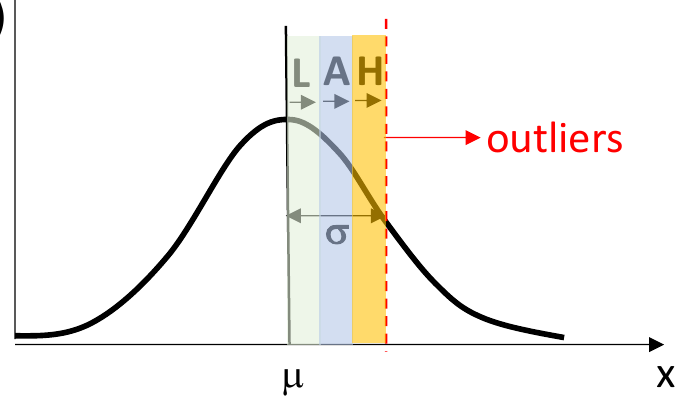
Figure 11. UX scoring and outliers condition (L: Low; A: Average; H: High): µ indicates the main value, and σ the standard deviation. g(x) is the Gaussian distribution function related to a specific UX attribute.